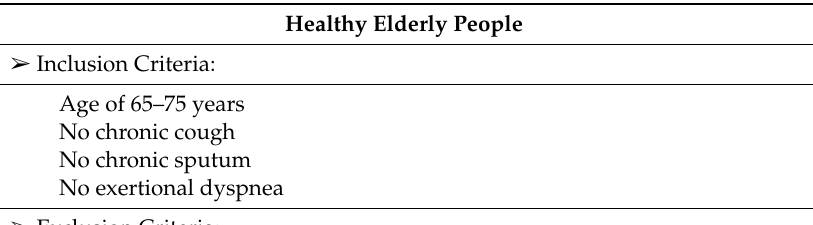
Table 1. Inclusion and exclusion